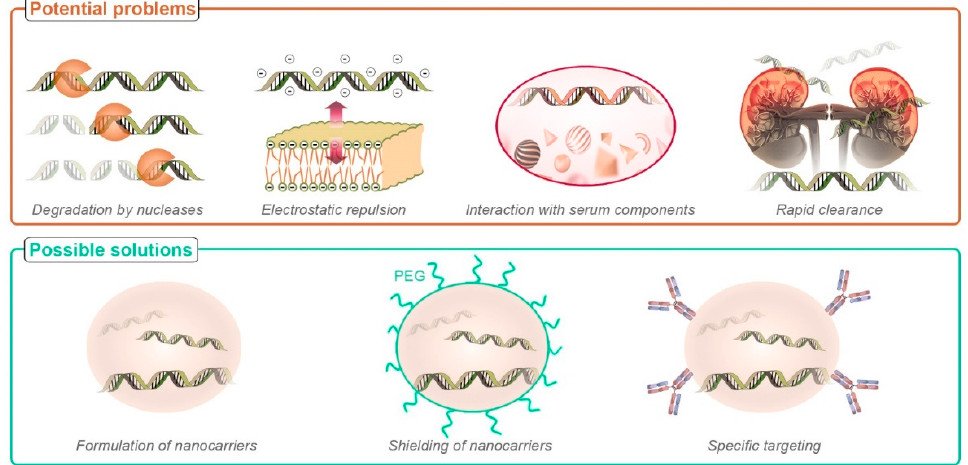
Figure 1. Various barriers to nucleic acid delivery and their possible solutions.